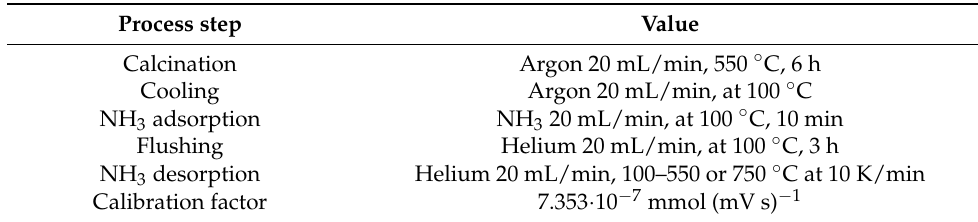
Table A3. Measurement conditions on Thermo Fisher Scientific TPDRO 1100 Series for characterizing the acidic properties of the prepared H-ZSM-5 zeolite samples.